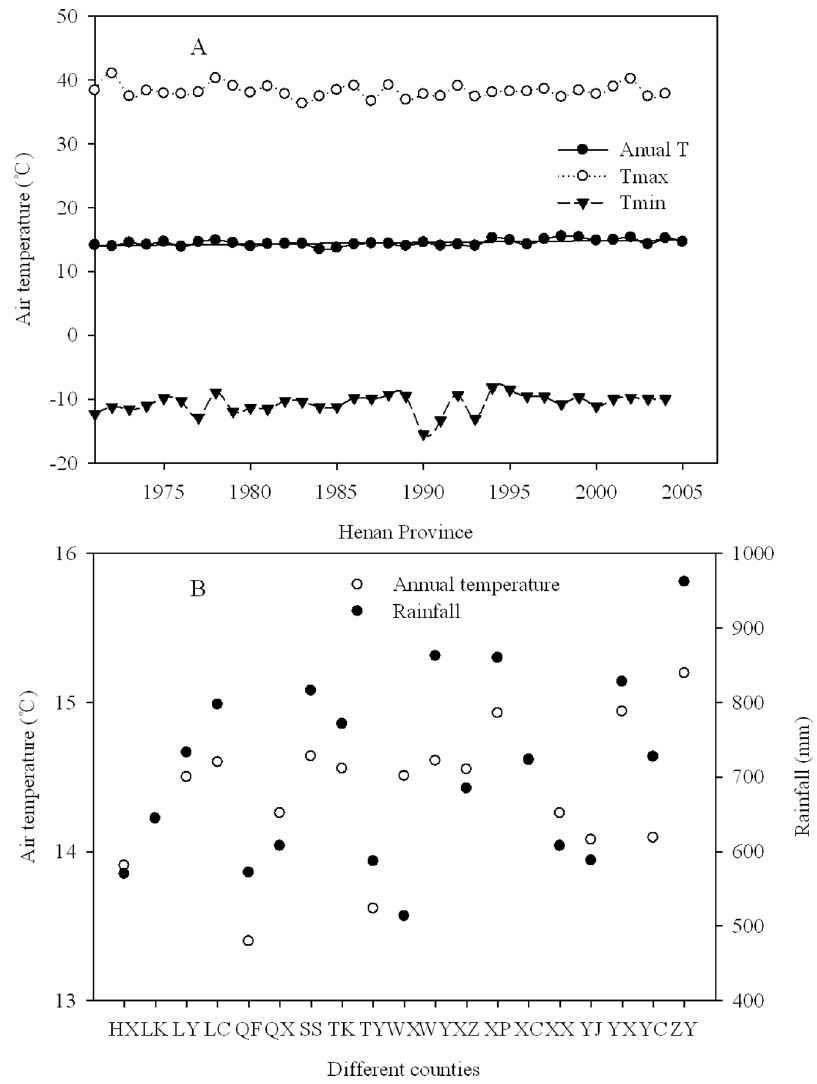
Figure 2. Average annual, maximum, and minimum temperature from 1971 to 2004 in Henan Province, China (A), and (B) average temperature and rainfall from 1975 to 2006 in different counties within Henan Province, China (B). See Table 1 for key to county name abbreviations. All these counties were arranged in English alphabetical order.